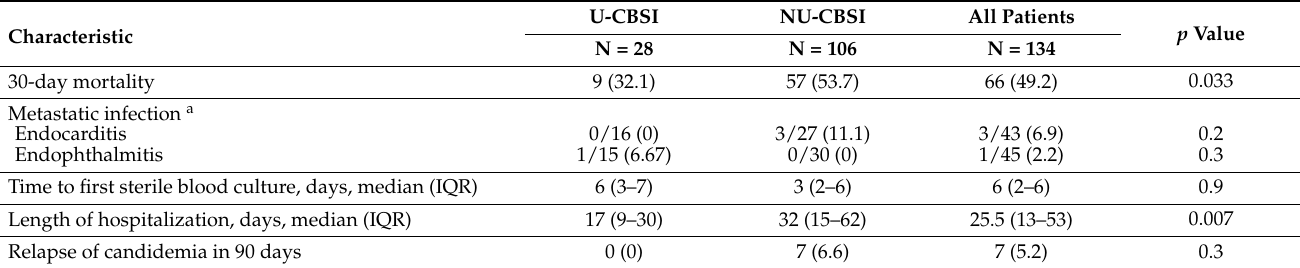
Table 3. Outcomes of urinary and non-urinary source candidemia.